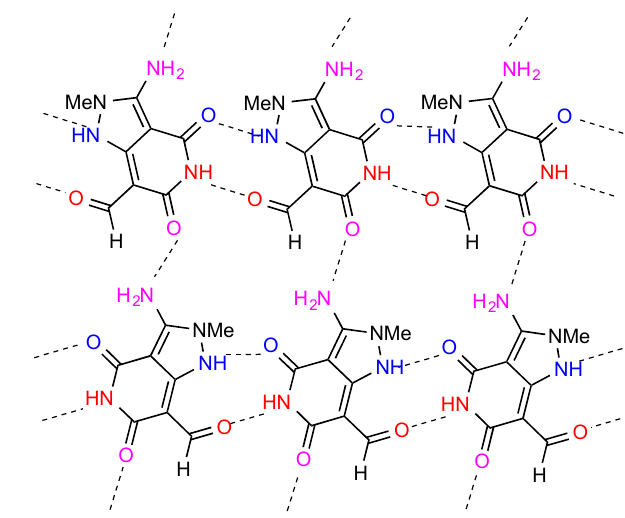
Figure 54. Structure adopted by compound 178.